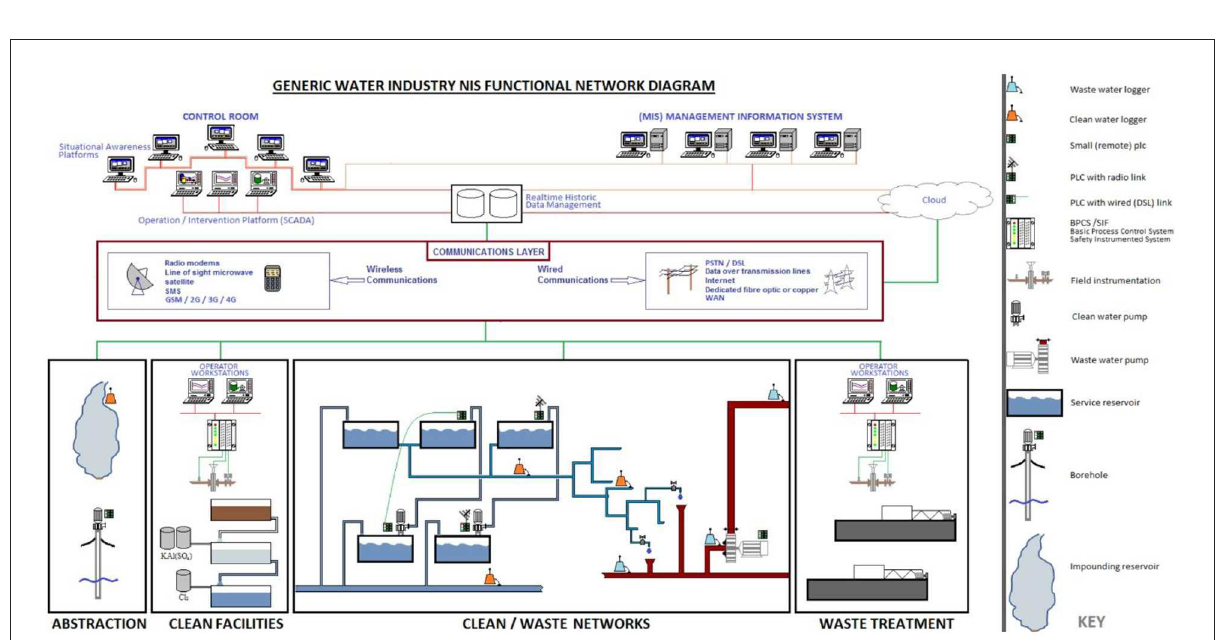
FIGURE2 The collection and use of data by a generic large UK water company—based on inside industry knowledge and information acquired from industry groups. The bottom of the diagram shows the field layer connected to the IT layer (at the top) via a telemetry